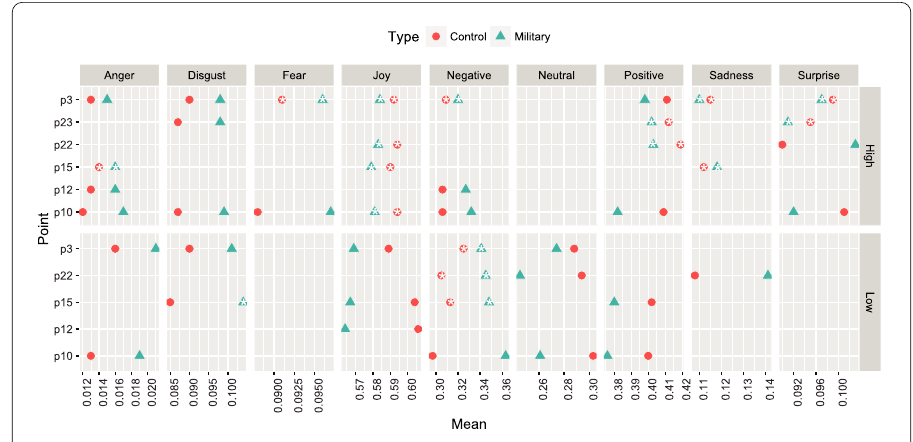
Figure 4 Mean affects during high vs. low ILI seasons across six Twitter sets. We only report differences that are statistically significant from the Mann-Whitney U test ( p -value ≤ 0.05); To control false positive